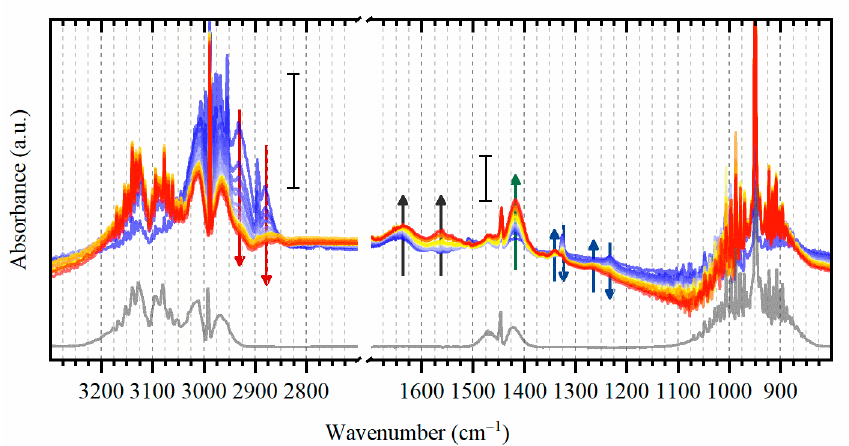
Figure 3. Evolution of experimental DRIFTS data (after normalization and subtraction of spectrum of the activated state) for Pd catalyst during exposure to ethylene at 50 °C (from blue to red) with the acquisition time of ca. 1 min. Grey line corresponds to the reference spectrum of gas-phase ethylene [71]. The scale bars demonstrate that the left part is enlarged with respect to the right one.